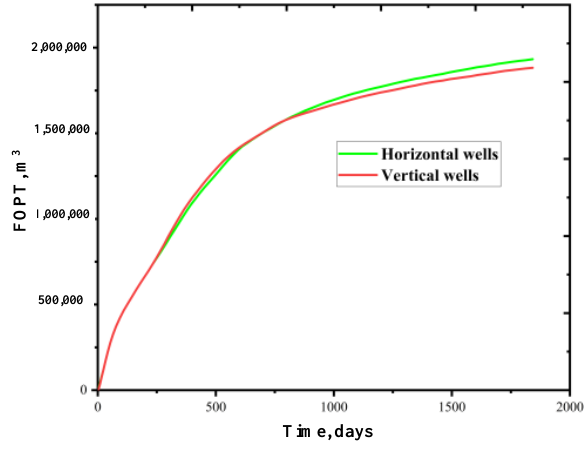
Figure 29. Field oil production total for horizontal and vertical wells.